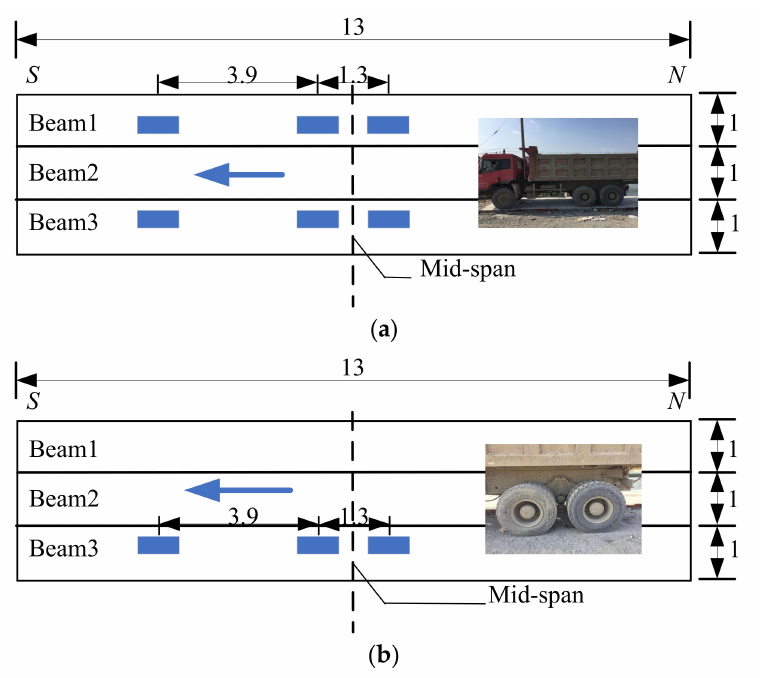
Figure 5. Truck load configuration (m). ( a ) Symmetrical loading. ( b ) Partial loading.